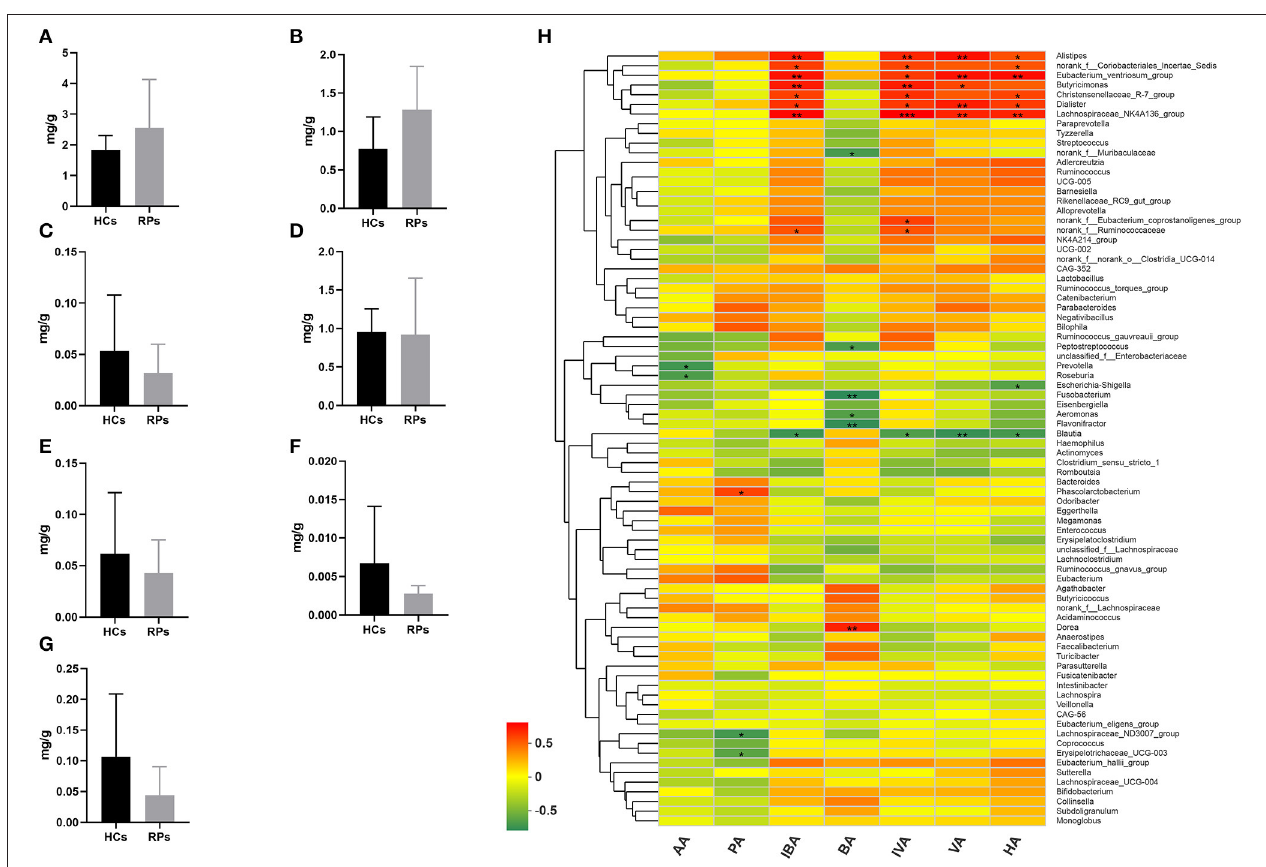
FIGURE 5 | The levels of SCFAs in the fecal samples of recovered patients and healthy controls. Examination of fecal samples of the two groups on levels of (A) Acetic acid (AA), (B) Propionic acid (PA), (C) Isobutyric acid (IBA), (D) Butyric acid (BA), (E) Isovaleric acid (IVA), (F) Valeric acid (VA), and (G) Hexanoic acid (HA). (H) Correlation between relative abundance of bacteria genera and levels of seven SCFAs. * p < 0.05; ** p <